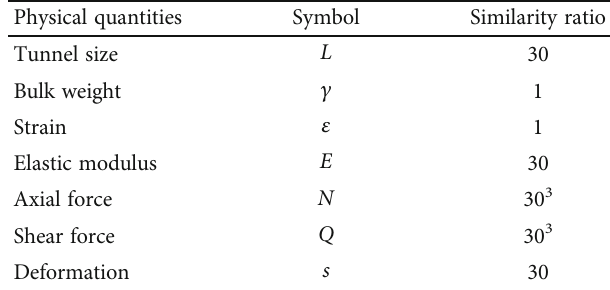
Table 1: Similarity